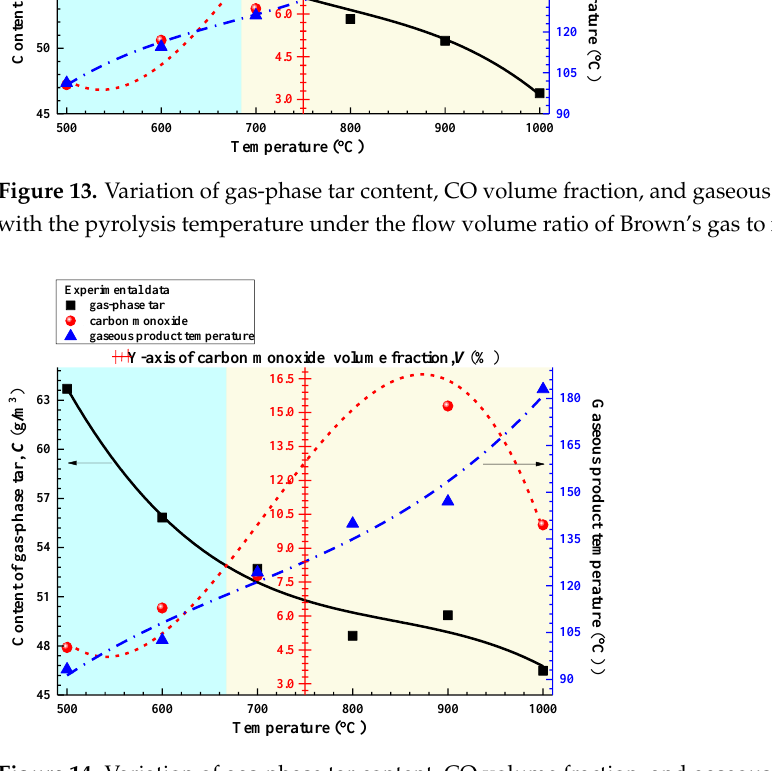
bond in gas-phase tar was the main source of CO. In this process, it absorbed the heat in the environment, resulting in the slowed down rise rate of gaseous product temperature ( T KN ). When the pyrolysis temperature was higher than T = 750 °C, the cracking rate of gas-phase tar decreased and the rise rate of gaseous product temperature ( T KN ) increased.